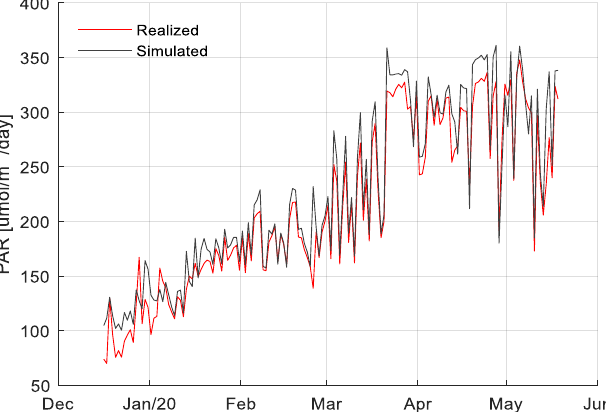
Figure A7. Measured and simulated average PAR ( µ mol / m 2 / d) after automated distillation of climate strategies during the experimental period (16 December 2019 until 29 May 2020) for one of the compartments (301).